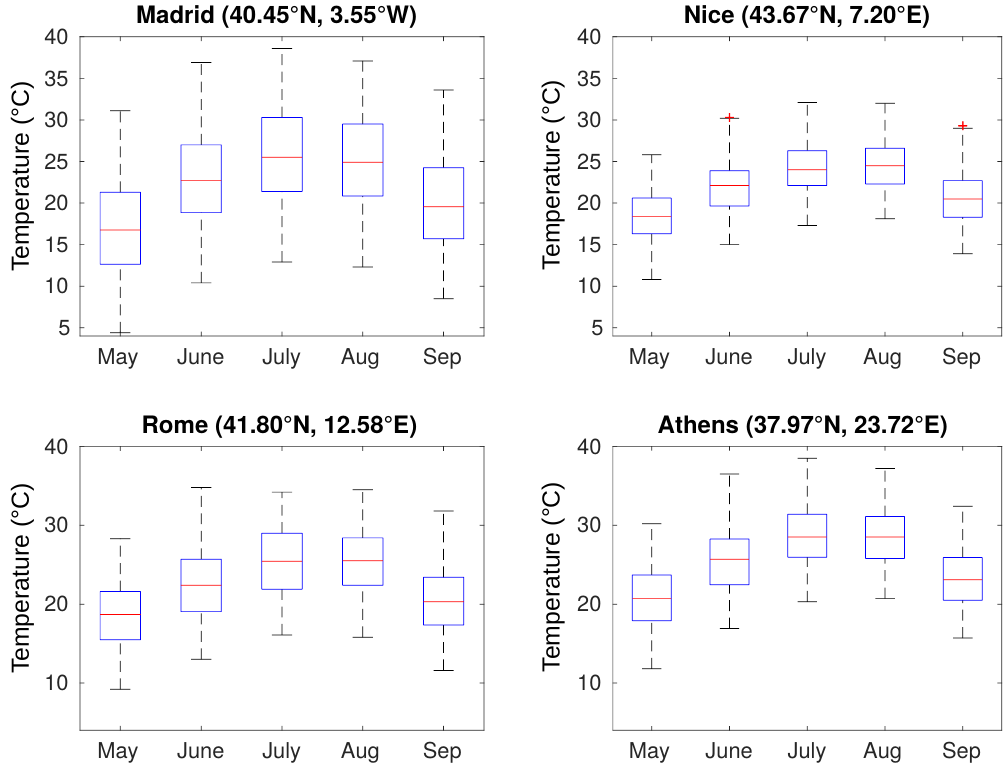
Figure 7. Outdoor air temperatures in the cities located below the 45th